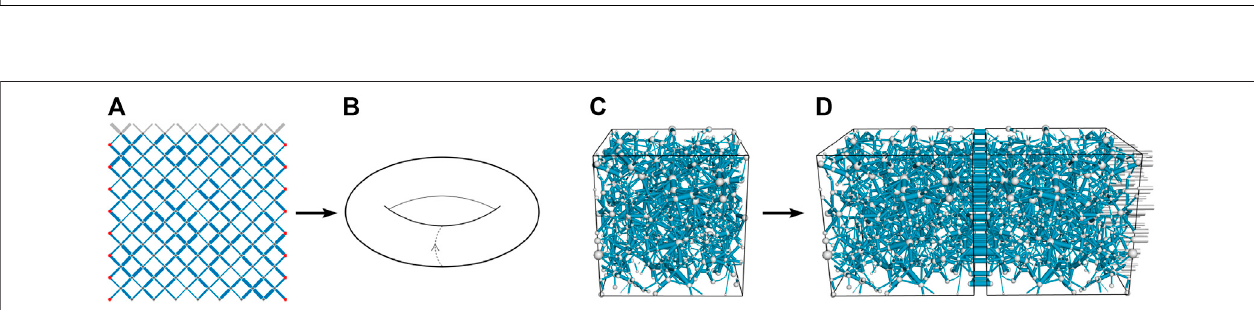
FIGURE8| Implementationofperiodicboundaryconditionsfor2Dand3Dnetworks.A2Dregularnetworkisshownin (A) whereperiodicboundaryconditionsare applied inboth the directions. Herethe overall fl owisin theupward directionand the gray linksat the toprow represent theghost links. Thelinks are drawnascylindrical tubesforthesimplicityofdrawing,buttheyarehourglassshapedintermsofthecapillarypressure.Thenodesaremarkedbysmalldotswherethereddotsattheleftand right edges represent identical nodes. This makes the fl ow essentially on the surface of a torus as shown in (B) where the arrow represents the effective fl ow direction.For3D,anetworkreconstructedfromBeriasandstoneisshownin (C) wheretheoverall fl owisfromlefttoright.Periodicboundaryconditionsareappliedinthe direction of fl ow by adding a mirror copy of the the network as shown in (D) . The ghost links at the right are colored by gray.